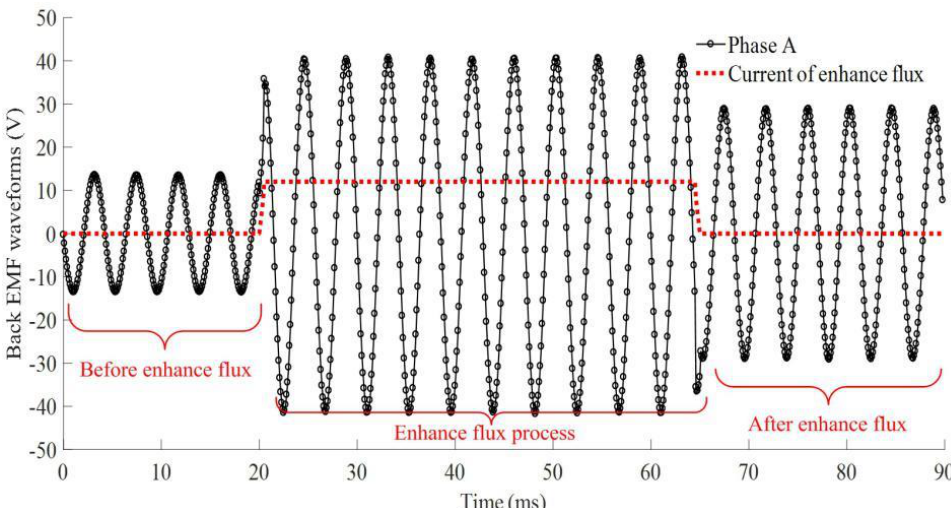
Figure 8. Enhance flux process of VFMPM machine.